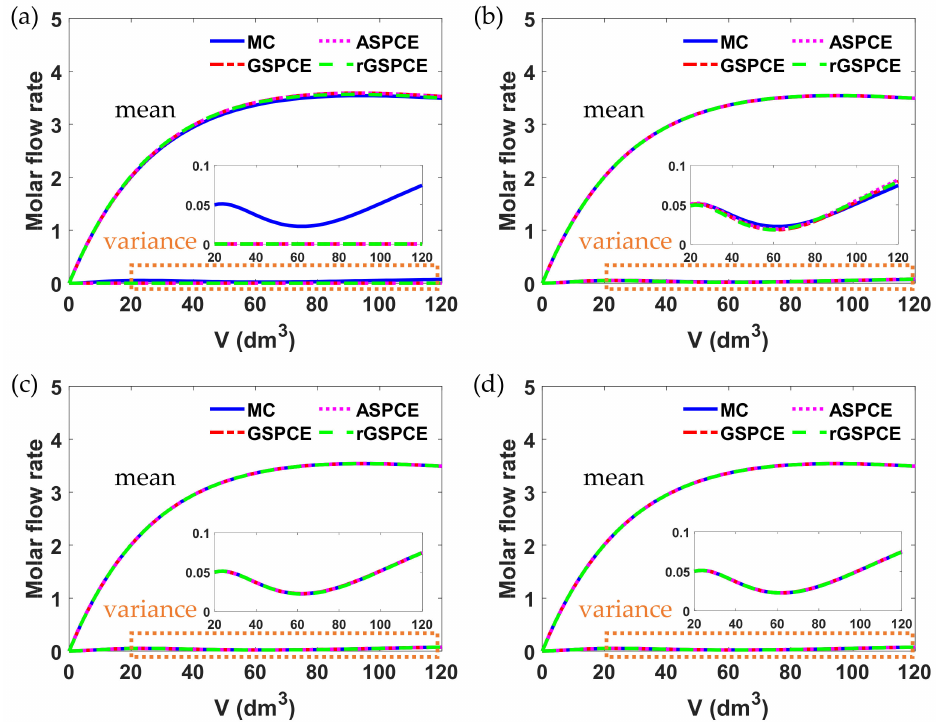
Figure 5. Simulation results of molar flow rate F B with different polynomial orders ( P ) in each case study: ( a ) P = 0, ( b ) P = 1, ( c ) P = 2, and ( d ) P = 3.